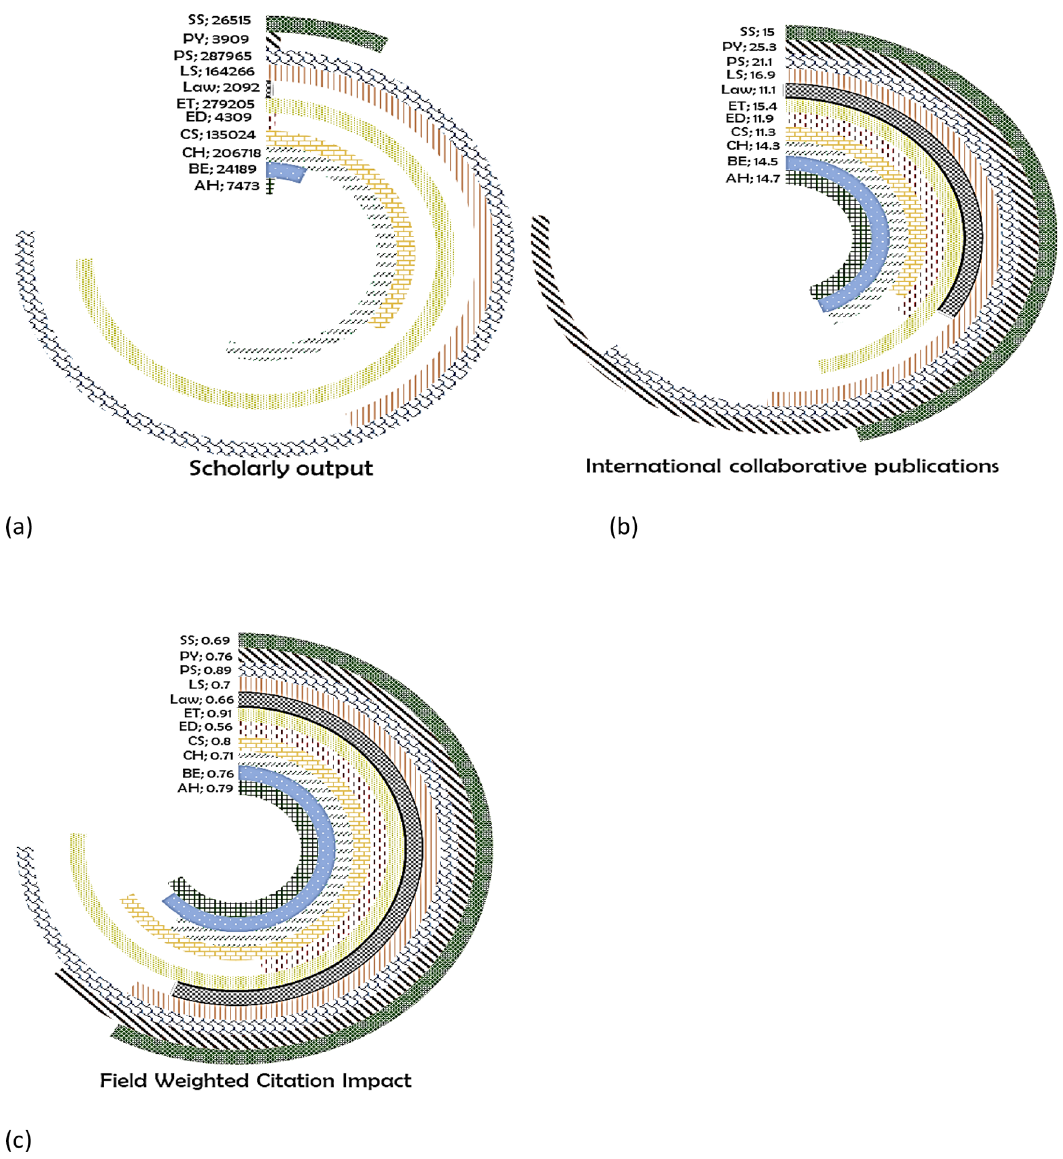
Figure 11. Subject wise split of India research outcome (a) scholarly output, (b) International collaboration and (c) FWCI. Arts & Humanities (AH), Business and Economics (BE), Clinical, pre-clinical and health (CH), Computer Science (CS), Education (ED), Engineering and Technology (ET), Life Science (LS), Physical Science (PS), Psychology (PY), Social Science